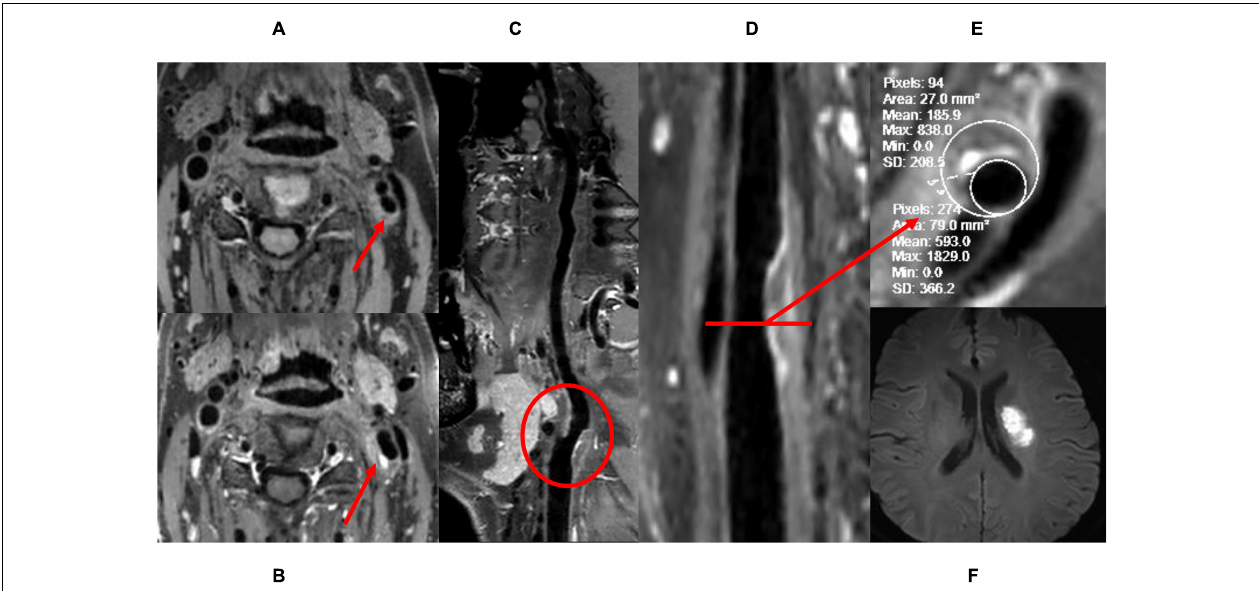
FIGURE 1 | The definition of high-risk plaque. (A) Pre-enhanced HRVW 3D T1 image, inhomogeneous intensity was seen in the plaque. (B) Post-enhanced HRVW 3D T1 image. Hyperintensity was seen in the plaque. (C,D) Reconstruction map of post-enhanced HRVW 3D T1 image. The whole vessel and a plaque shown in red circle were better displayed. (E) Section image perpendicular to the lumen in the plaque lesion. Stenosis rate was determined in this section. (F) DWI. Hyperintensity was seen in left basal ganglia, indicating cerebrovascular events occurred.